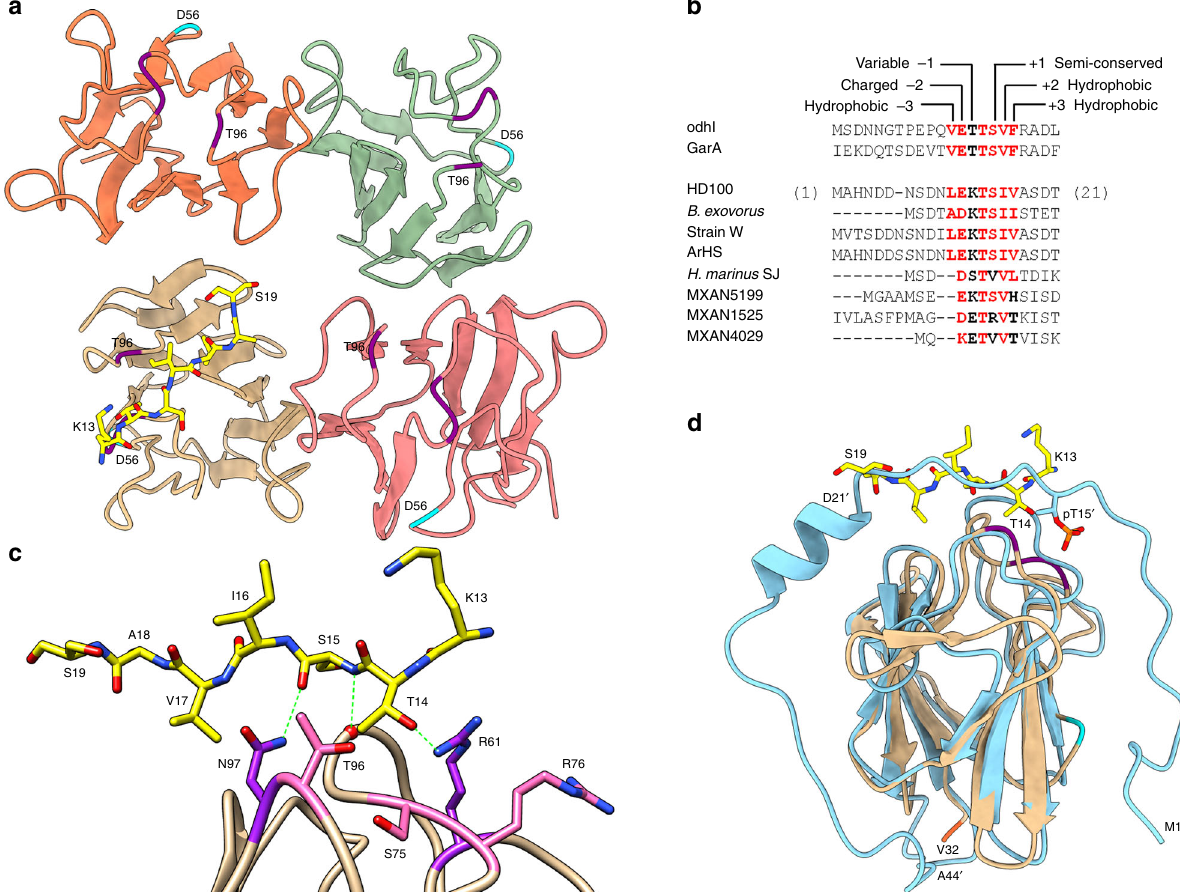
Fig. 2 Structure and analysis of a DgcB tail-FHA construct lacking the GGDEF domain. a The asymmetric unit of this form contains four FHA domains, arranged at ~90 ˚ to each other, with each replicating the D56-mediated FHA:FHA interactions of the full-length structure (via symmetry mates at edge of tetramer, not shown in fi gure). One of the four tail regions is ordered (peptide K13-S19, colored yellow) binding across the recognition cleft of a FHA domain, suggestive that the DgcB peptide ligand is derived from self. b ) Sequence alignment of N-terminal tails of known self-interacting FHA domains (Mycobacterial GarA and OdhI) with DgcB and selected homologues (DgcB equivalents from fi ve Bdellovibrio strains and three similar M. xanthus FHA: GGDEF proteins). The properties of six positions ( − 3 to + 3) fl anking the central Thr of the binding motif are annotated. c Interaction between the DgcB tail peptide and FHA domain, hydrogen bonds shown as green dashed lines. Peptide recognition is driven by two groupings of residues that line a cleft of the FHA domain (near grouping colored pink, far grouping purple; cleft is easily discerned in a where both groups are colored purple). d Structural overlay of DgcB FHA:tail complex (FHA tan, tail yellow) with that of OdhI (blue, PDB code 2KB3, residue numbers denoted by prime). The peptide ligands of both DgcB and OdhI bind in a similarly extended conformation, with DgcB T14 and OdhI pT15 ’ projecting into a conserved pocket on their respective FHA